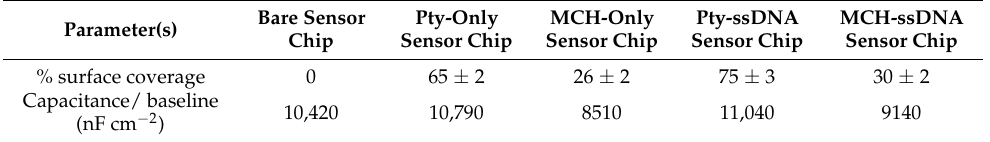
Table 1. Pty-film- and MCH-SAM-modified sensor chip surfaces with their % coverage and capacitances. Bare Sensor Parameter(s)